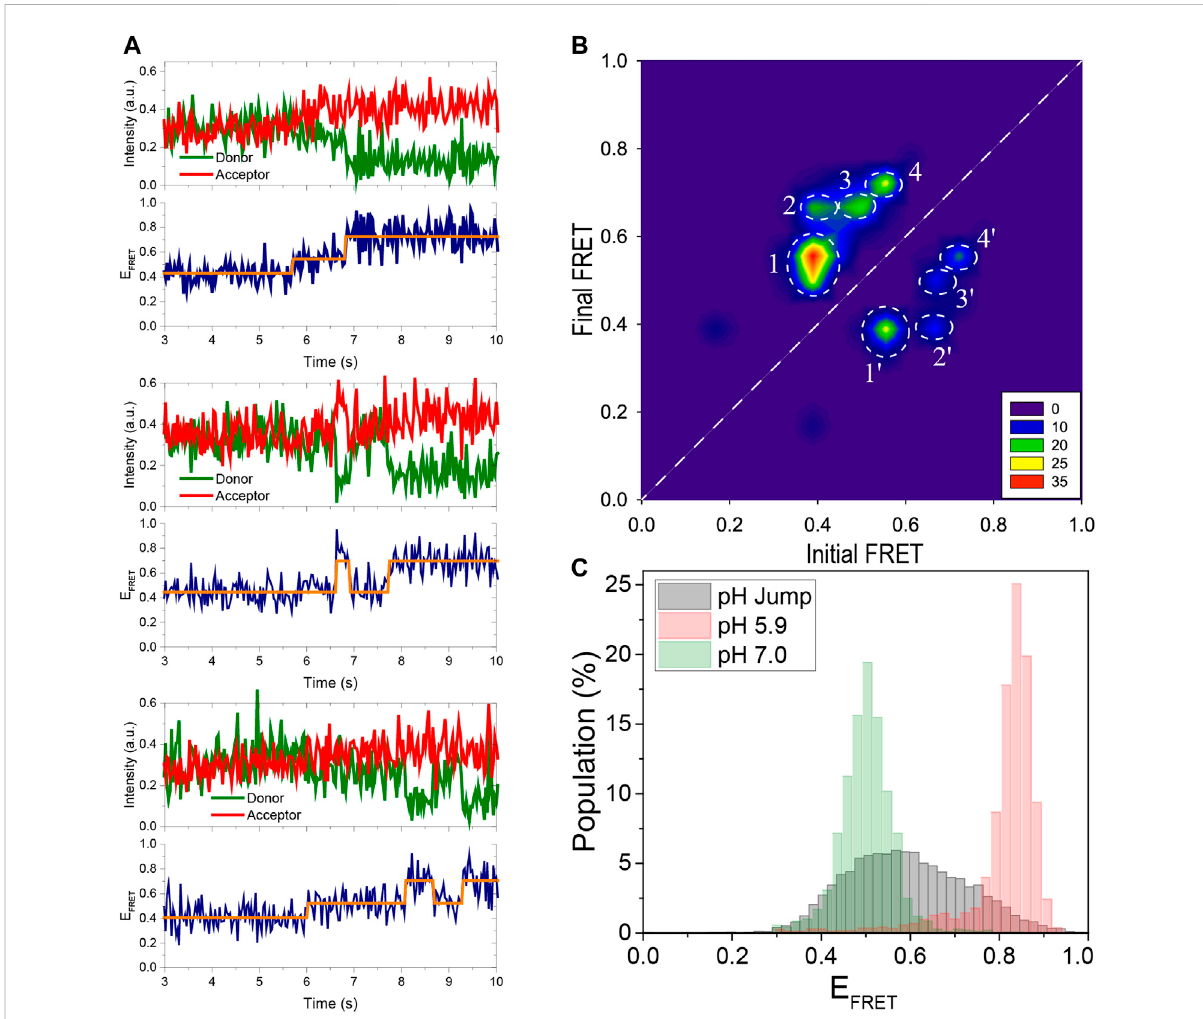
FIGURE 4 Using pH jump measurements, the folding process is monitored in real time. (A) Three representative FRET time traces are shown. As the pH is decreased from 7.0 to 5.3, the DNA molecules convert from an unfolded to a folded state. The traces show distinct intermediate states that were detected using HMM analysis (the orange lines overlaid on the data). As shown in the middle and bottom traces, the i-motif occasionally transitions from a folded state to the unfolded state (middle trace) or to an intermediate state (bottom trace) before refolding. (B) A contour plot of the transitions from 105 molecules shown in the TDP. The notable transitions are denoted by white circles and are numbered 1, 2, 3, and 4 in the folding direction. The reverse of these transitions in the unfolding direction are numbered 1 ′ , 2 ′ , 3 ′ , and 4 ′ . All folding and unfolding processes involve intermediate states between the completely unfolded E FRET ≈ 0.40 and completely folded E FRET ≈ 0.75 states. (C) The gray histogram is constructed from the FRET levels spanning the interval 2 s before and 2 s after the transition. This representation emphasizes the contribution of intermediate states that are absent in steady-state histograms obtained 30 min after the buffer exchange. For comparison, the steady state distributions at pH 7.0 (completely unfolded) and pH 5.9 (completely folded) are depicted with green and red histograms, respectively, as a